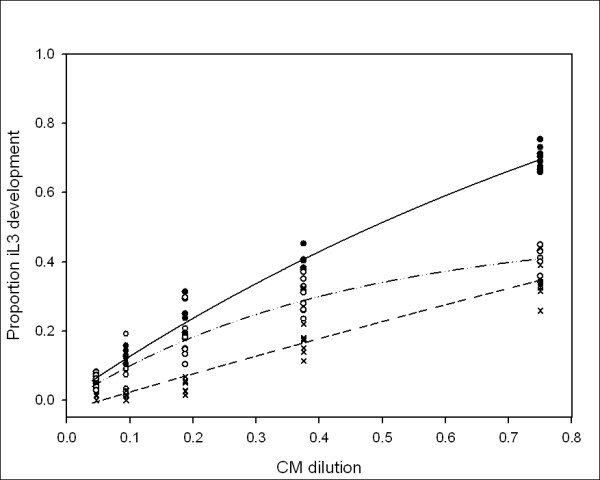
The effect of various food concentrations on the proportion of P. trichosuri iL3 development in response to conditioned medium concentration. L1 larvae at one individual per microliter were incubated at 20°C in various concentrations of bacterial food source and gentamicin sulfate at 50 μg/μL and serially diluted conditioned medium. Solid line and circle is 0.3% w/v HB101, n = 3249; dashed line and open circle is 0.4% w/v HB101, n = 3174; dotted line and cross is 0.5% w/v HB101, n = 2762. On day 5, the proportion of larvae that had developed into iL3 was scored in six replicate wells. The lower the food concentration available, the more likely the larvae will develop as infective larvae.